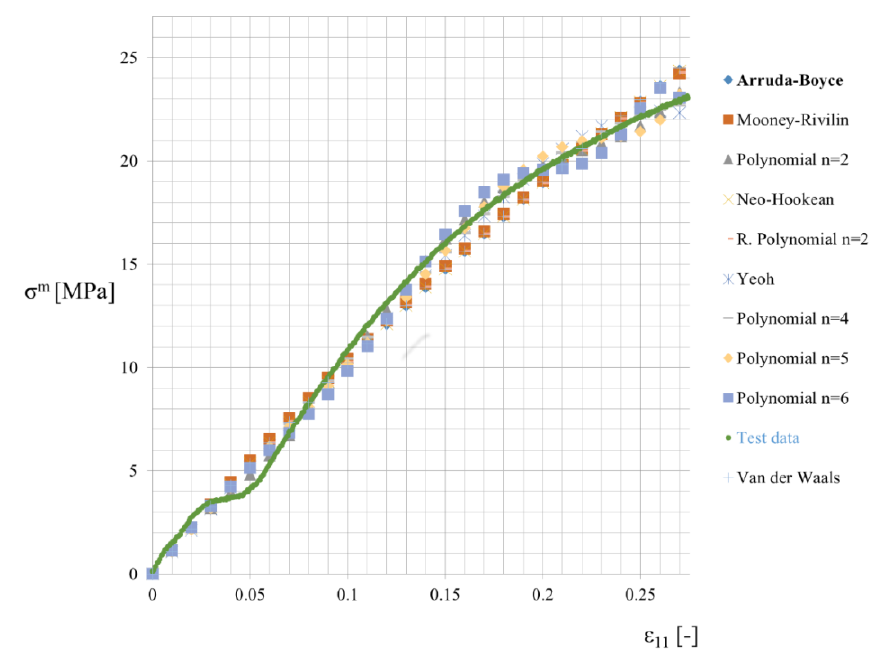
Figure 5. Uniaxial stretch approximations for Laripur LPR 5020.